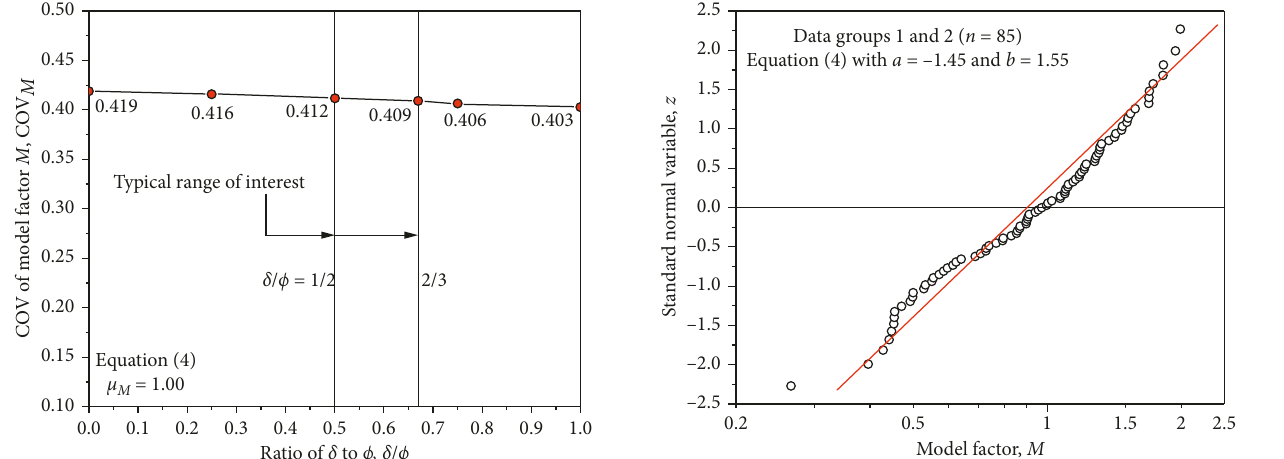
Figure 5: Influence of ratio of δ to ϕ on optimization outcomes of COV of model factor (COV M ) for Equation (4).